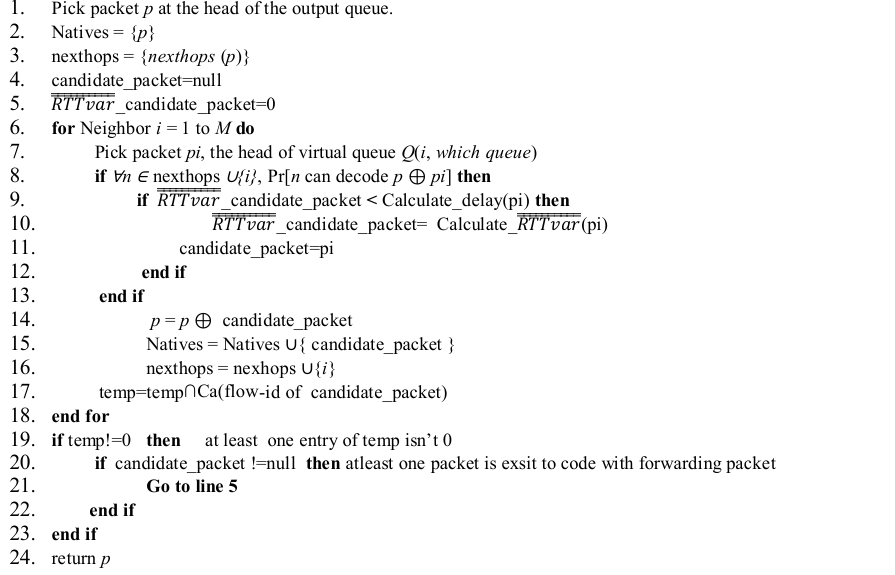
Fig. 3. Coding structure of proposed